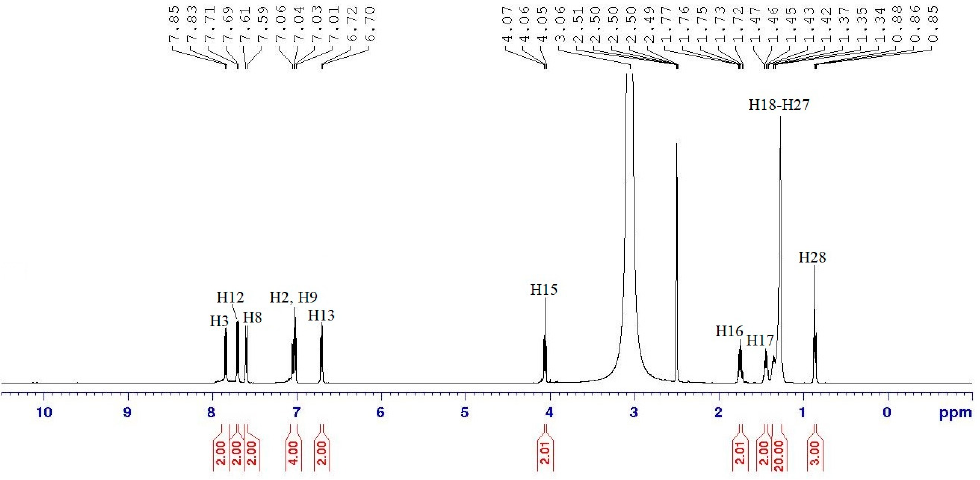
Figure 5. 1 H-NMR spectrum of compound 6e .